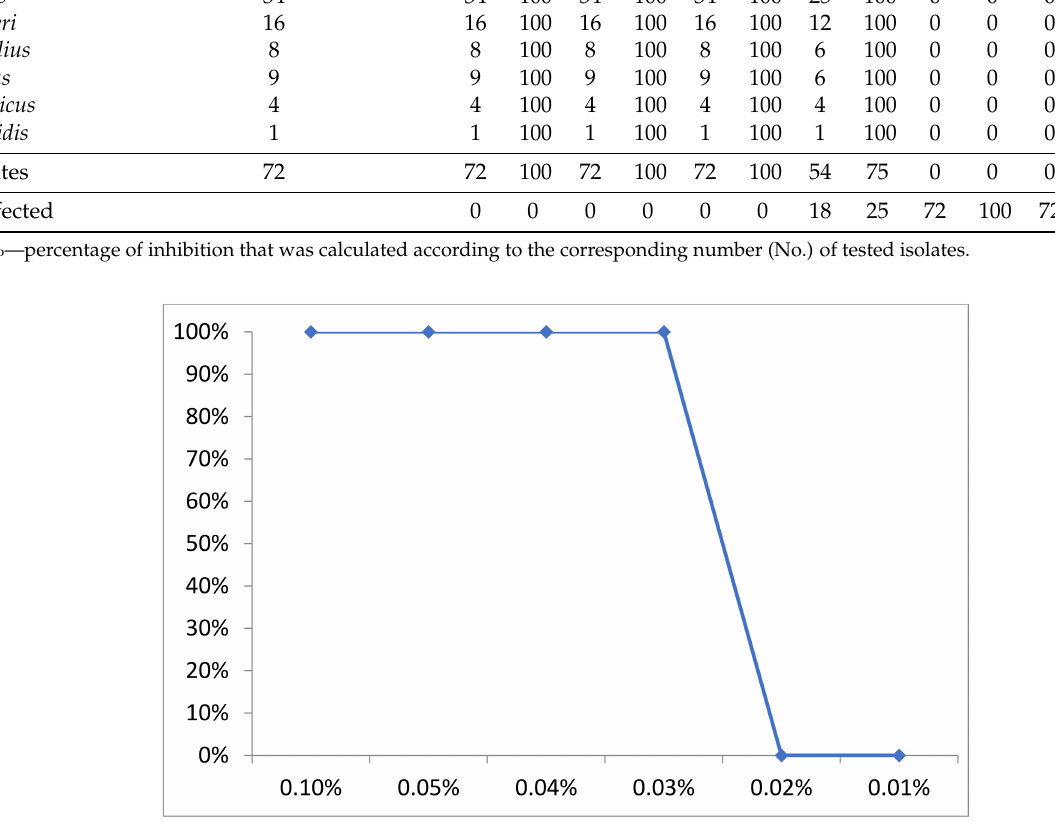
Bacterial Isolates No. of Tested Isolates